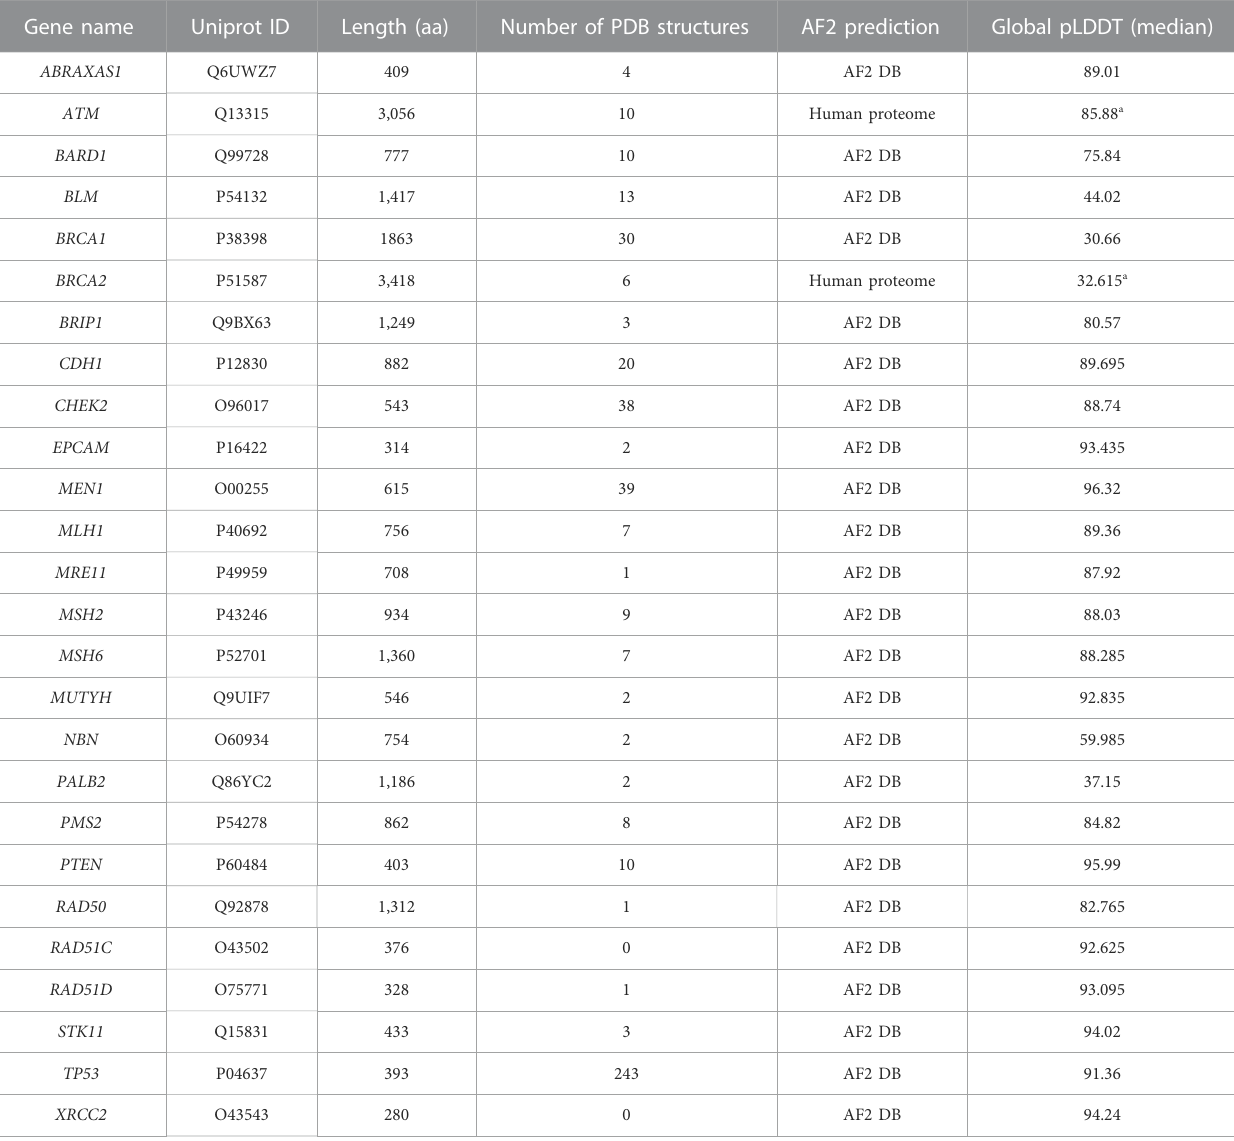
TABLE 3 Summary of experimental and AF2 structures of 26 genes. Gene